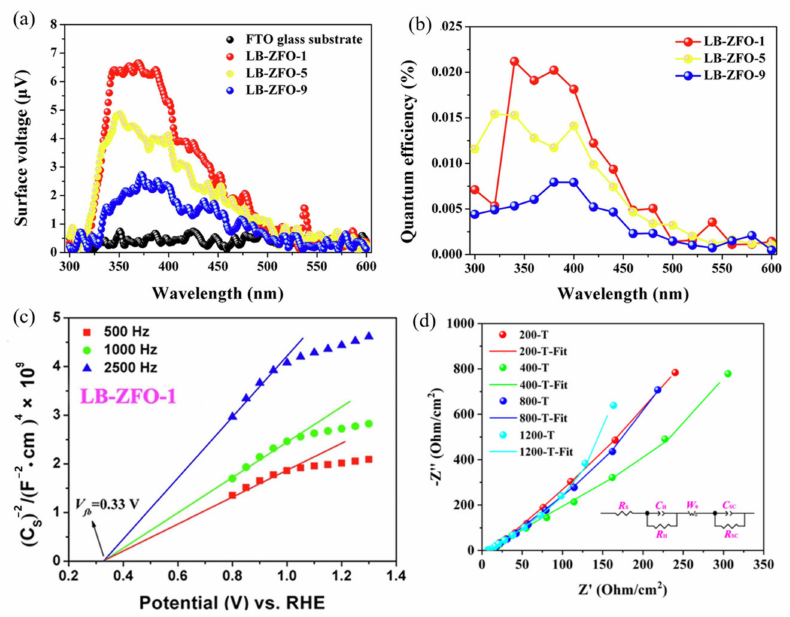
Figure 16. The LB-ZFO-1, LB-ZFO-5 and LB-ZFO-9 films: ( a ) surface photovoltage; ( b ) apparent quantum efficiency; ( c ) Mott–Schottky plots of LB-ZFO-1; ( d ) electrochemical impedance spectroscopy spectra [117] (reprinted with permission from [117] Zhu et al., 2020).